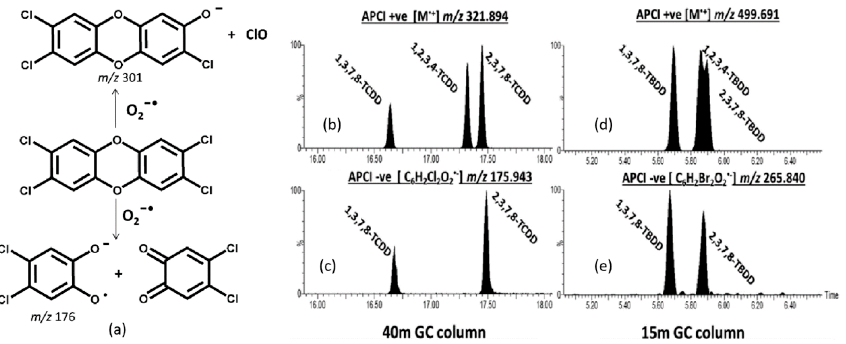
Figure 5. ( a ) Scheme of reaction between 2,3,7,8-TCDD and O 2 −• ; ( b – e ) APCI − spectra of 2,3,7,8- TCDD, 2,3,7,8-TBDD, and 2,3 Br-7,8 Cl-DD. Ether cleavage products (ECPs) are observed at m/z 176 and 266 for the 2,3,7,8-TCDD and 2,3,7,8-TBDD species. Both of these ECPs are observed for the 2,3 Br-7,8 Cl-DD. Reproduced with permission from Ref. [103]. Copyright 2016 American Chemical Society.